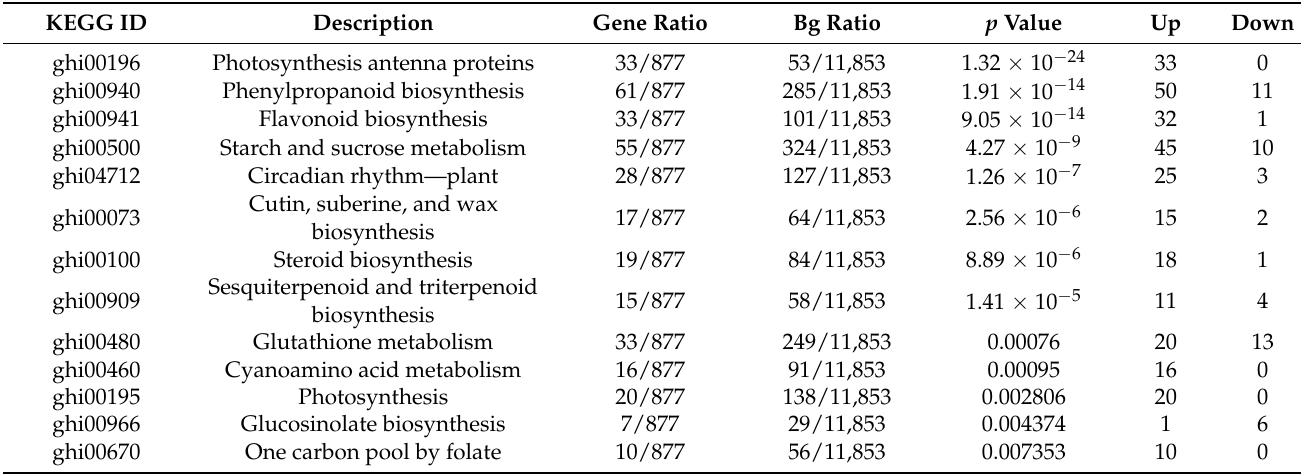
Figure 8. Transcriptome sequencing of differences in cotton transcriptome expression after GhEXO70A1-A gene silenc- ing. ( A ) GhEXO70A1-A expression levels after virus-induced gene silencing (VIGS). Relative GhEXO70A1-A expression levels in plants numbered 4, 6, 9, 10, 12, and 16 significantly decreased. ( B ) Correlation analyses of transcriptome sam- ples. ( C ) Differential gene volcano map in transcriptome. ( D ) Differential gene heat map in transcriptome. ( E ) KEGG functional enrichment dot plot of DEGs. ( F ) GSEA diagram showing changes in photosynthesis antenna proteins after EXO70A1 gene silencing. ( G ) GSEA diagram showing changes in photosynthetic pathway after EXO70A1 gene silencing. ( H ) GSEA diagram showing changes in circadian rhythm pathway after EXO70A1 gene silencing. Data are means of three replicates ± SD. ** p < 0.01. Table 4. DEG function pathway